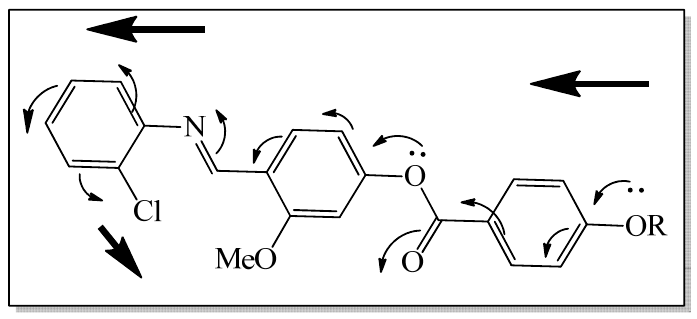
Figure 4. Conjugation of molecules, In .